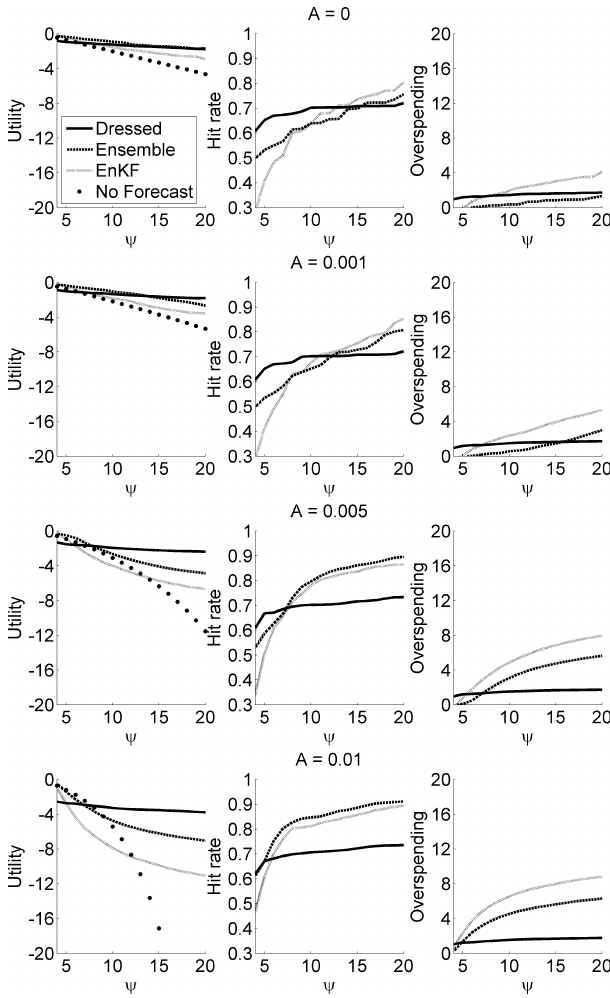
Figure 9. Utility, hit rate and overspending as a function of param- eter ψ for the three flood forecasting systems for various levels of risk aversion for the decision maker, when spending is allowed in- differently at any lead time.